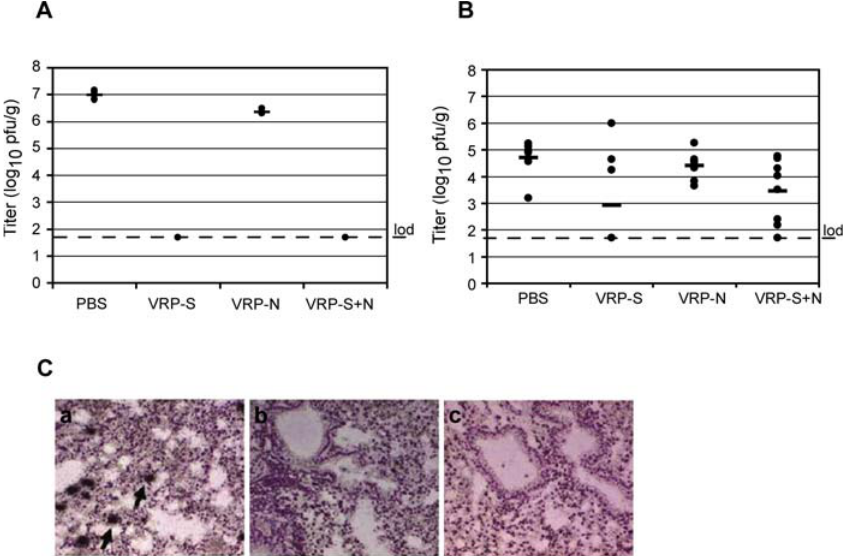
Figure 4. VRP-S Induces Short-Term Protection against icGDO3-S in Young and Partial Protection in Old Mice (A) Lung titers of BALB/c mice vaccinated and boosted with 10 6 IU of VRP-S, VRP-N, a combination of VRP-S plus VRP-N (VRP-S þ N), or mock vaccinated with PBS, then challenged with 10 5 pfu of icGDO3-S challenge ( n ¼ 8 per group). Lungs were harvested 2 d post-challenge. (B) Lung titers of aged BALB/c mice vaccinated at greater than 26 wk of age, boosted 4 wk later, then challenged 12 wk post-boost with icGDO3-S ( n ¼ 7 VRP-N, n ¼ 8 for other groups). Tissue was harvested 4 d post-challenge. (C) SARS CoV specific in situ signal (black arrows) was observed in the lungs of senescent mice that were vaccinated with PBS (unpublished data) or VRP-N (a) and challenged with icGDO3-S, although overall, the signal appeared to be less intense than that observed in the icSARS challenge animals (Figure 2C). Vaccination with VRP-S (b) or VRP-S þ N (c) failed to induce complete protection from icGD03-S challenge, as sections from two of five S- and three of four S þ N-vaccinated animals exhibited signal above that of uninfected controls.